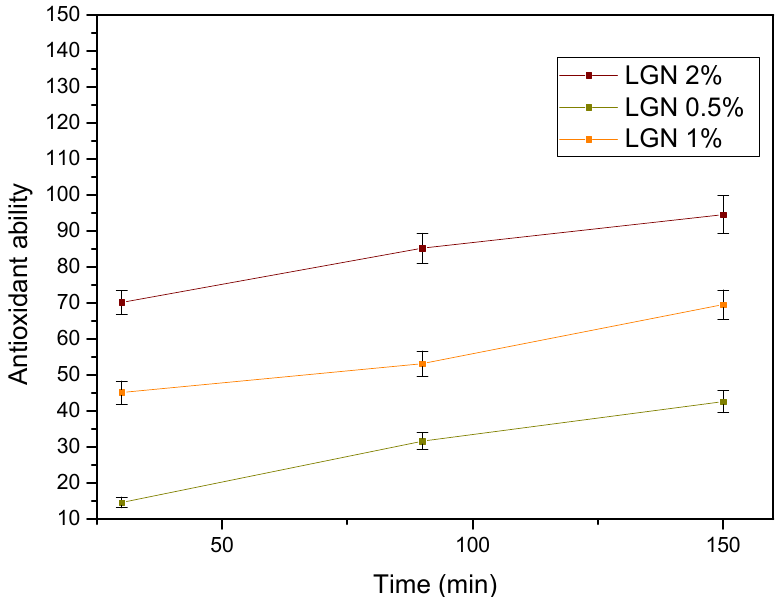
Figure 8. Antioxidant ability of emulsions during the first 2.5 h.